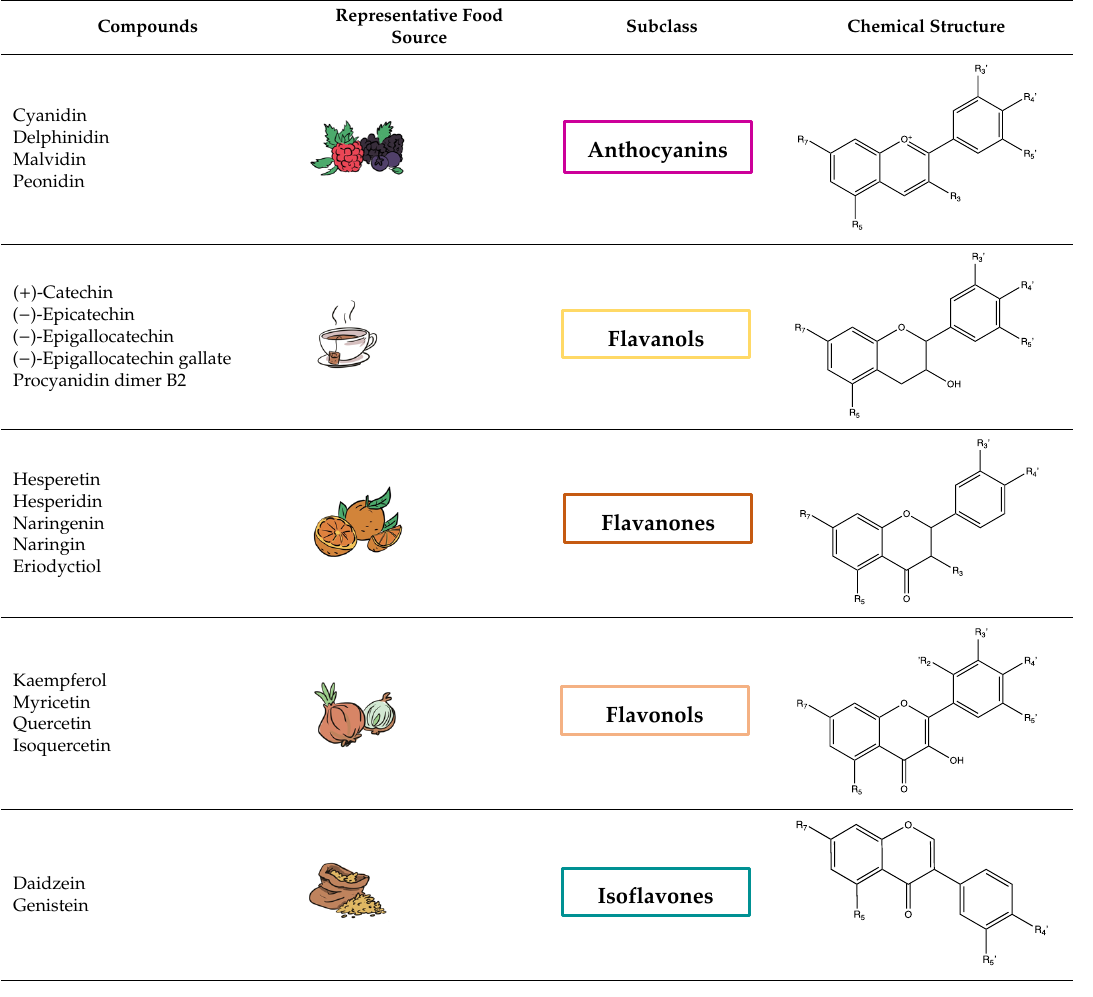
Table 1. Flavonoids subclasses: compounds, representative food sources and chemical structures.